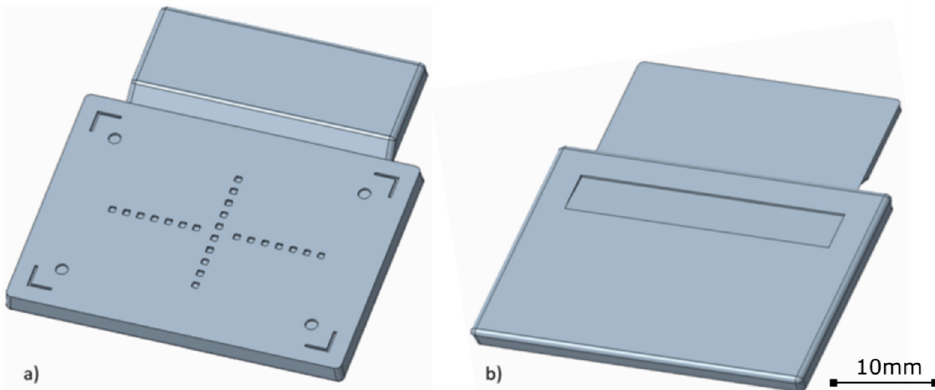
Figure 2. ( a ) one side of the platelet design was used to implement measurement features for shrinkage and warpage. ( b ) on the other side a tilted area for surface optimization was implemented.